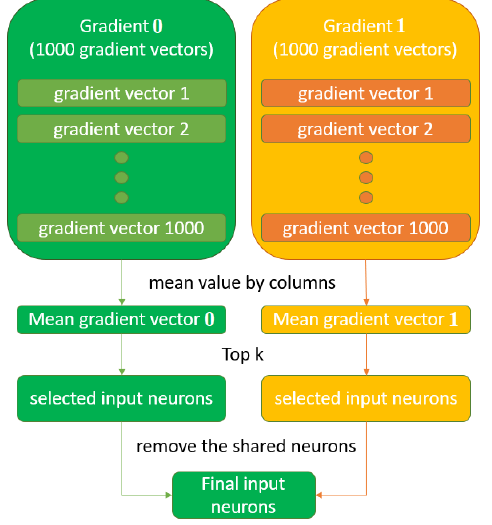
Figure 5. The process to select the input neurons with highest impact on the